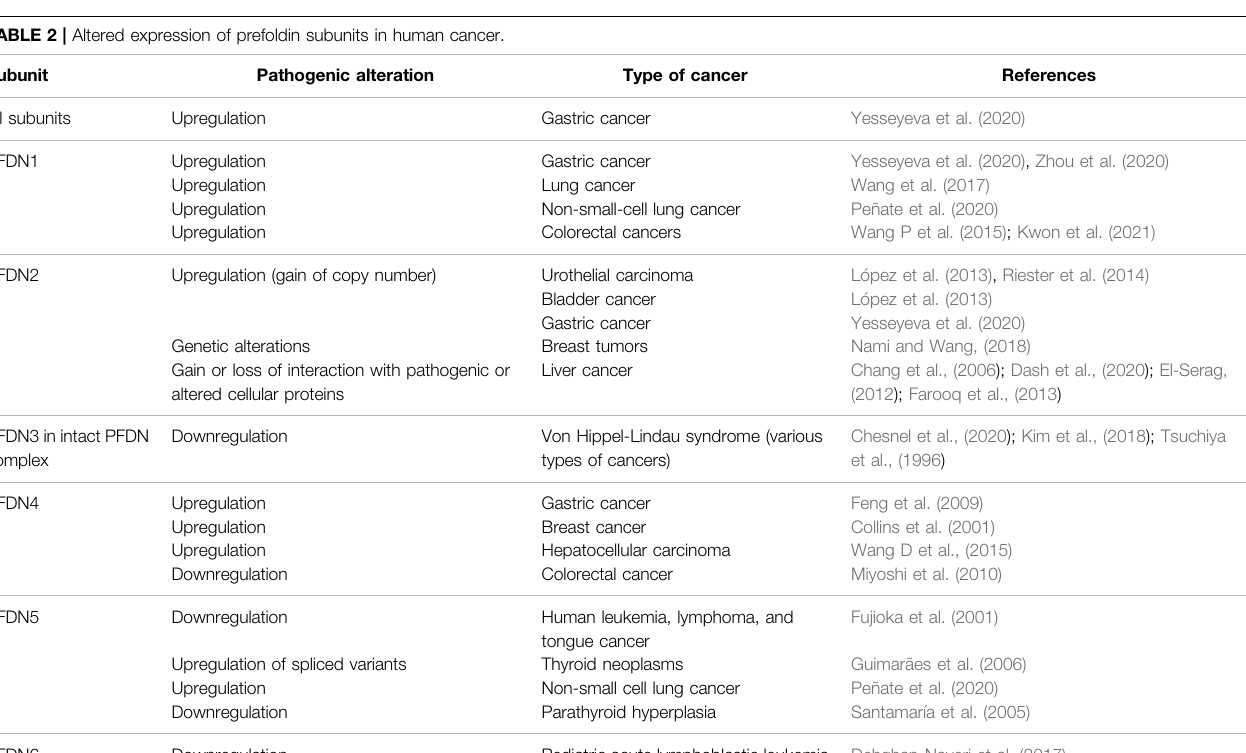
TABLE 2 | Altered expression of prefoldin subunits in human